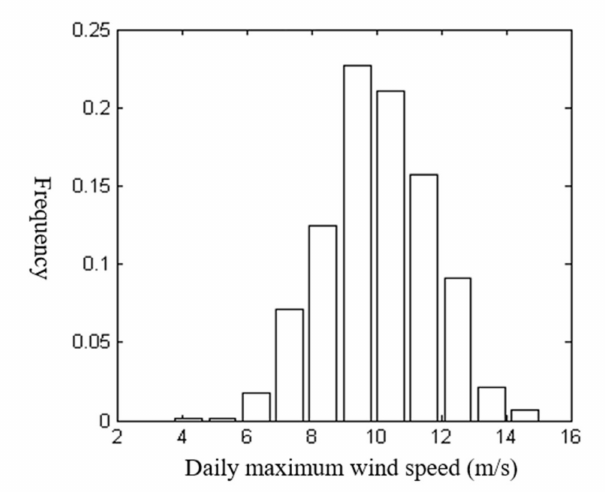
Figure 7. The distribution of the daily maximum wind speed.